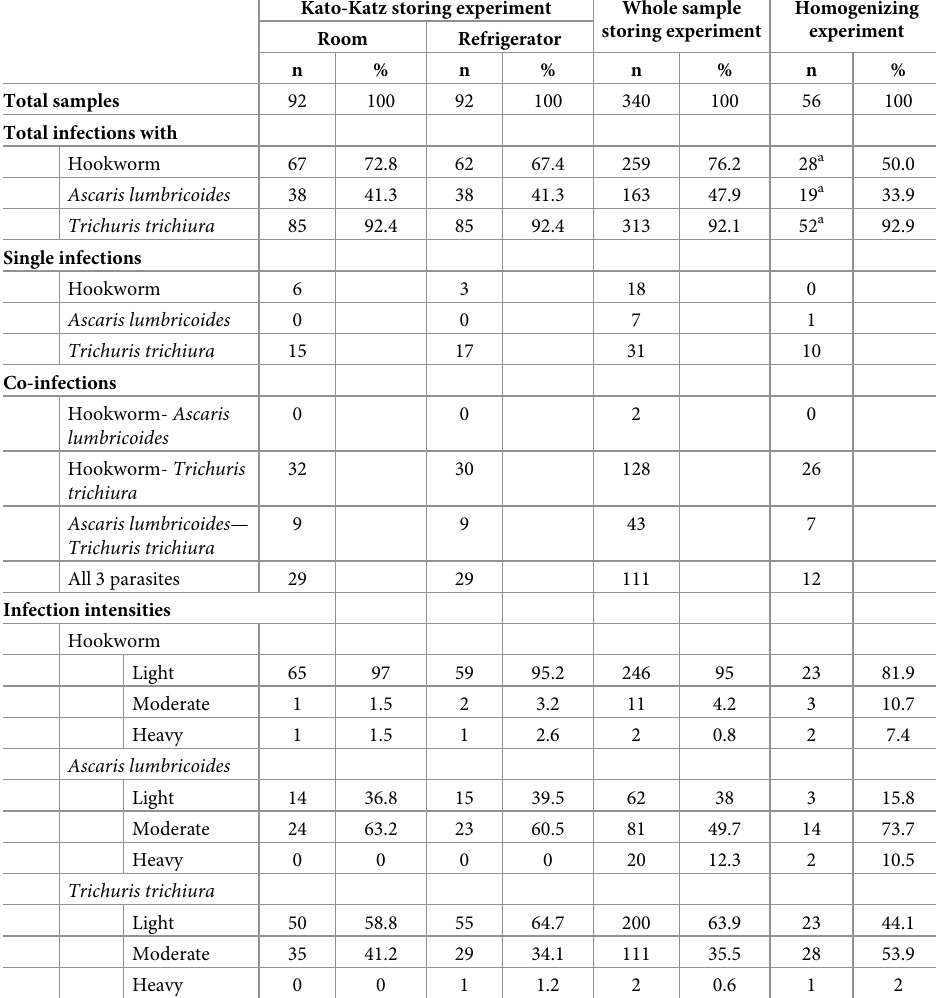
Kato-Katz storing experiment Whole sample